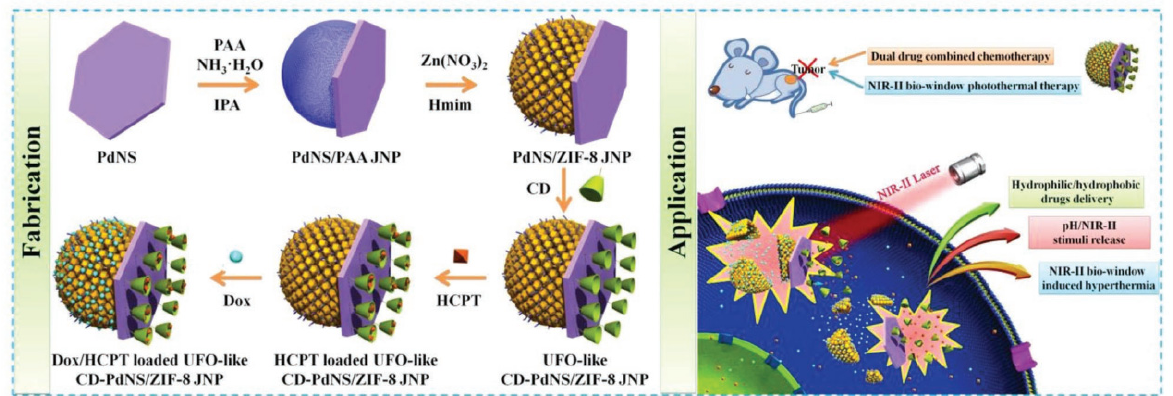
Figure 3. Schematic diagram of preparing the Janus nanoparticle for an in vitro and in vivo pH and NIR ‐ II (1064 nm) dual ‐ triggered synergistic dual ‐ drug chemotherapy and photothermal therapy